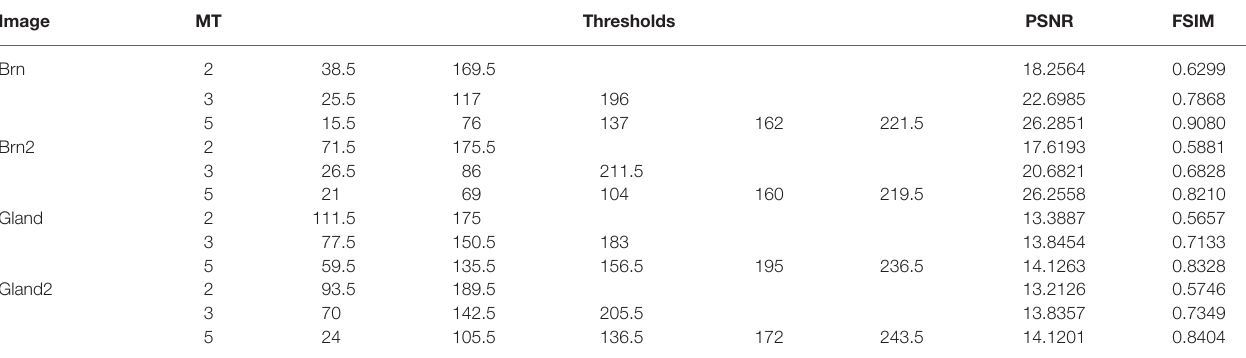
TABLE 6 | The experimental result data with medical images. Image MT